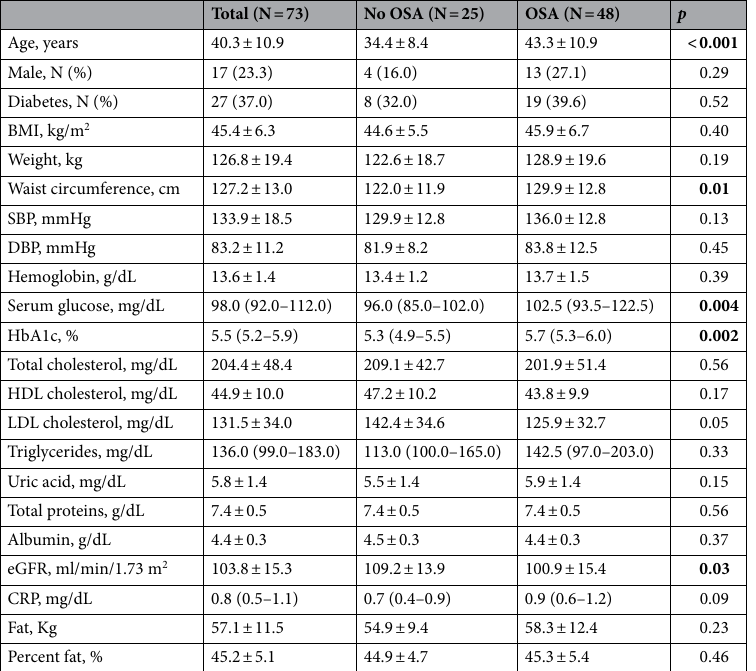
Table 1. Baseline characteristics of the study population. Data are expressed as mean ± SD, median with IQR, or percent frequency, as appropriate. Bold values are statistically signifcant. BMI—body mass index; CRP—C reactive protein; DBP—diastolic blood pressure; eGFR—estimated glomerular filtration rate; HbA1c—glycated hemoglobin; HDL—high-density lipoprotein; LDL—low-density lipoprotein; SBP—systolic blood